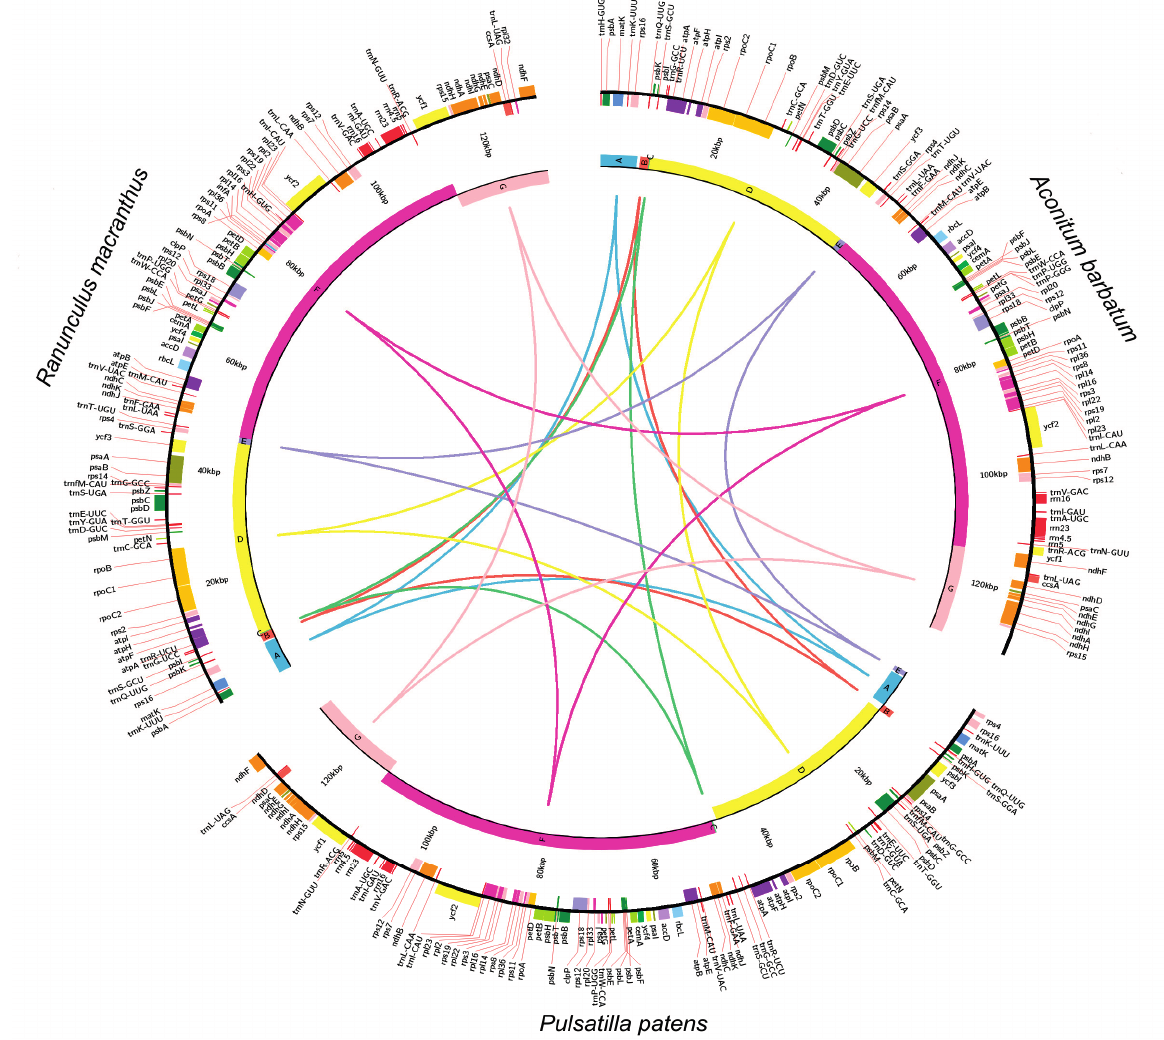
Figure 2. A reciprocal comparison of cpDNA maps of Aconitum barbatum , Ranunculus macranthus and Pulsatilla patens . cpDNA molecules are circular, but they are presented as linear in this figure, excluding the second inverted repeats (IR) region, for easy comparison. Color boxes from the outermost to innermost indicate: (i) genes with counterclockwise transcriptional orientation; (ii) genes with clockwise transcriptional orientation; and (iii) locally-collinear blocks (LCBs), labelled A–G, whose orientation is identical to or opposite of that of Aconitum . Orthologous LCBs marked with the same colors and letters are connected by lines. The original, linear Mauve figure is shown in Figure